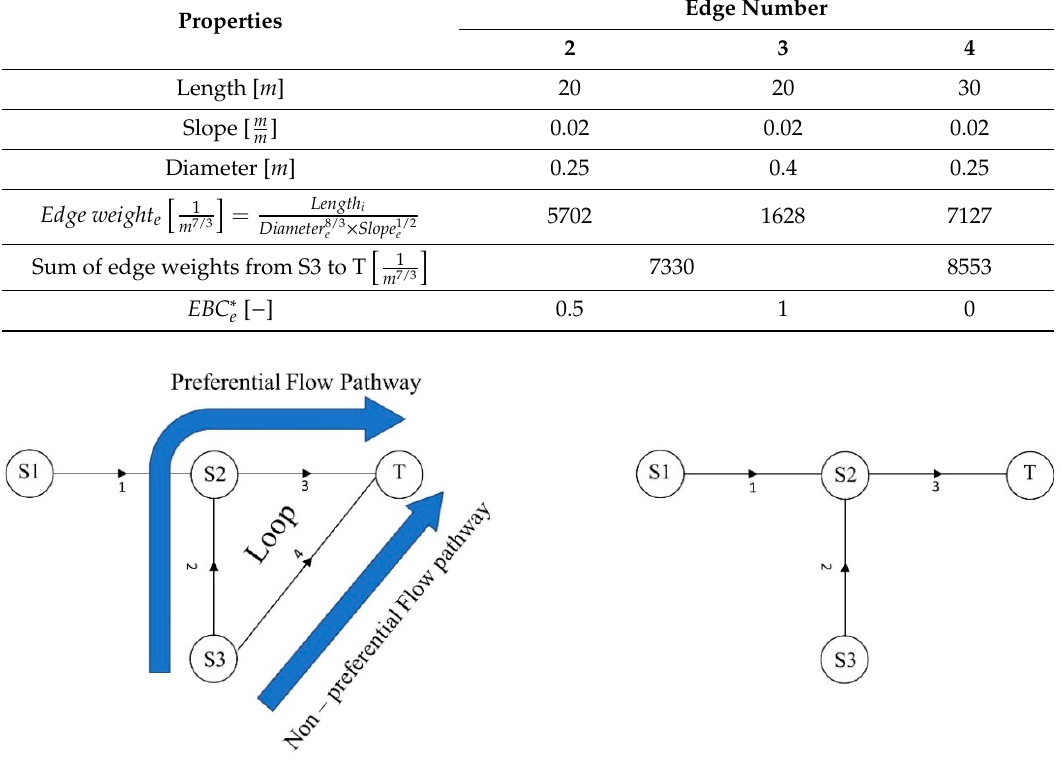
Figure1. Removingadditionalpipeinloopedstructurebyremovingtheedge, restinginnon-preferential Figure 1. Removing additional pipe in looped structure by removing the edge, resting in non- flow pathway: looped structure ( left ); tree structure ( right preferential flow pathway: looped structure ( left ); tree structure ( right ).